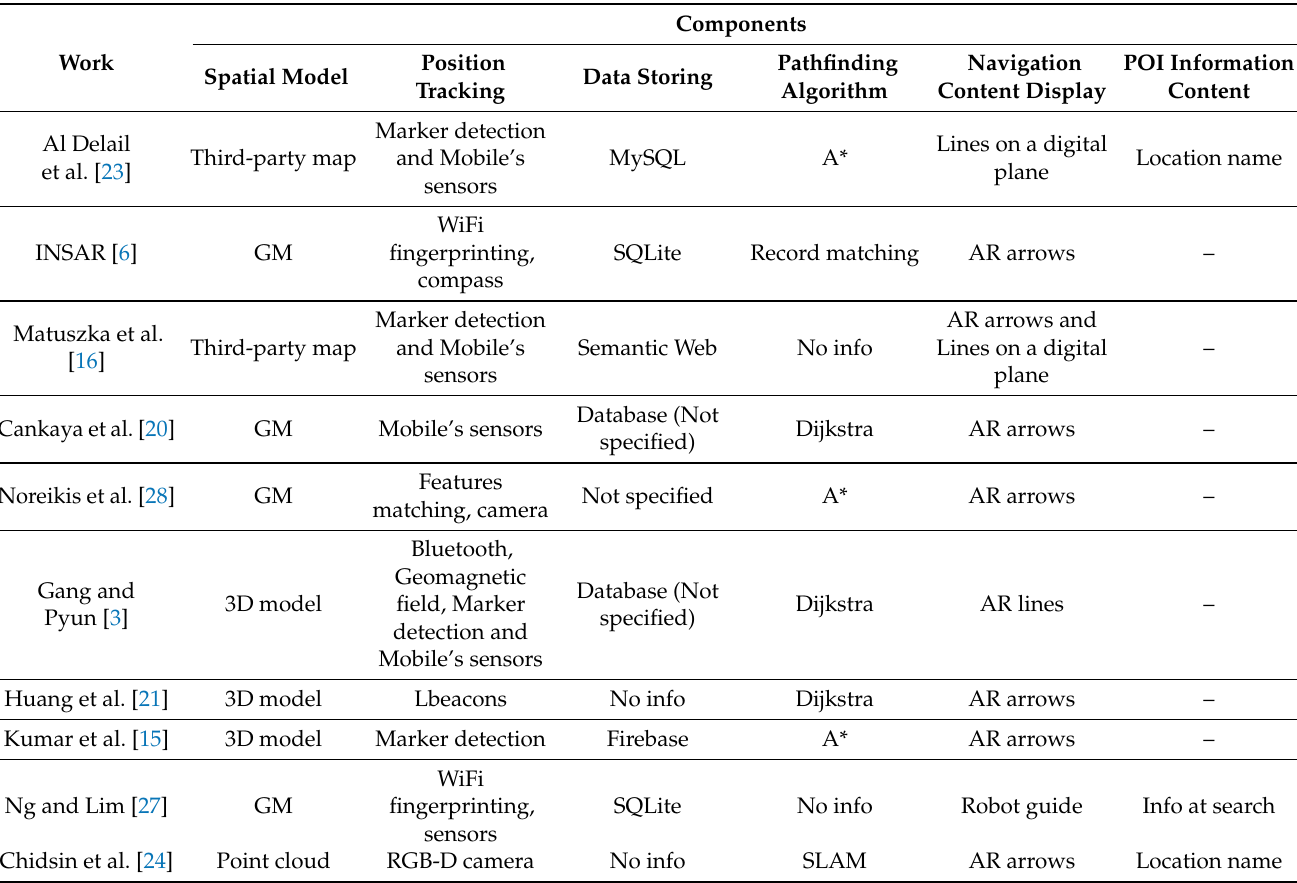
Table 1. Indoor navigation system components. Some options refer to Graph Model (GM) or those Not Implemented